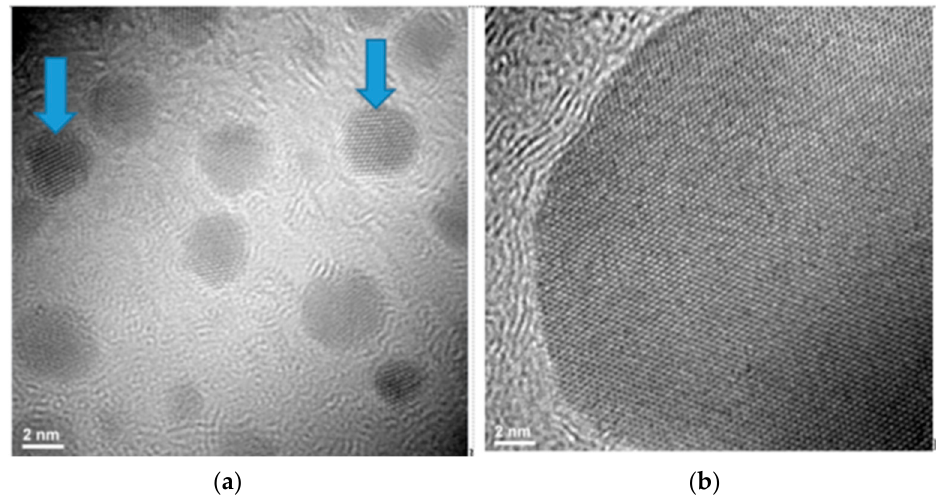
Figure 8. Structure of nanoparticles with twinned planes formation for samples RT1 ( a ) and RT3 ( b ).